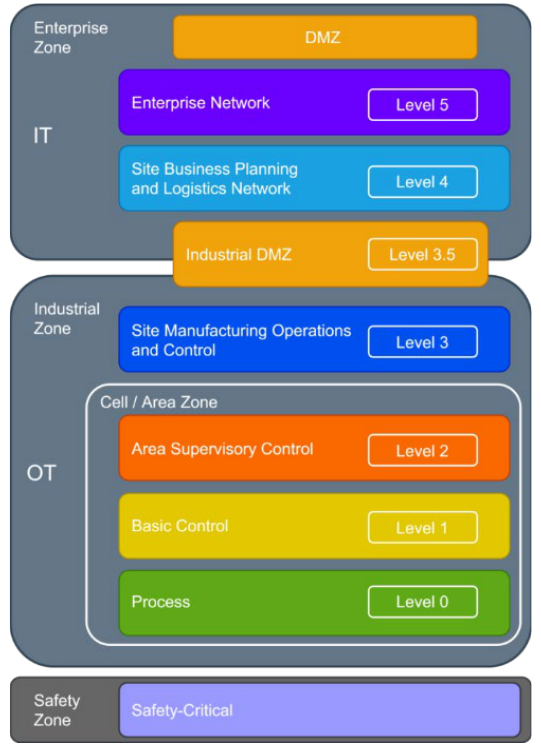
Figure 1. Structure of the PERA (Purdue Enterprise Reference Architecture)